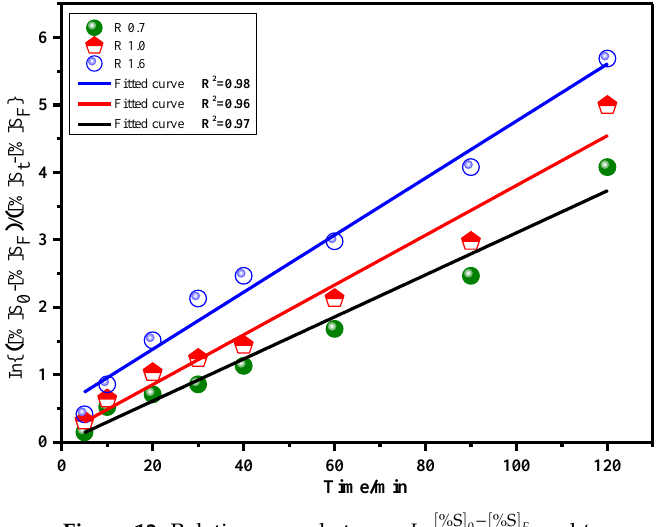
Figure 12. Relation curve between I n Figure 12 . Relation curve between 𝐼n Figure 12 . Relation curve between 𝐼n